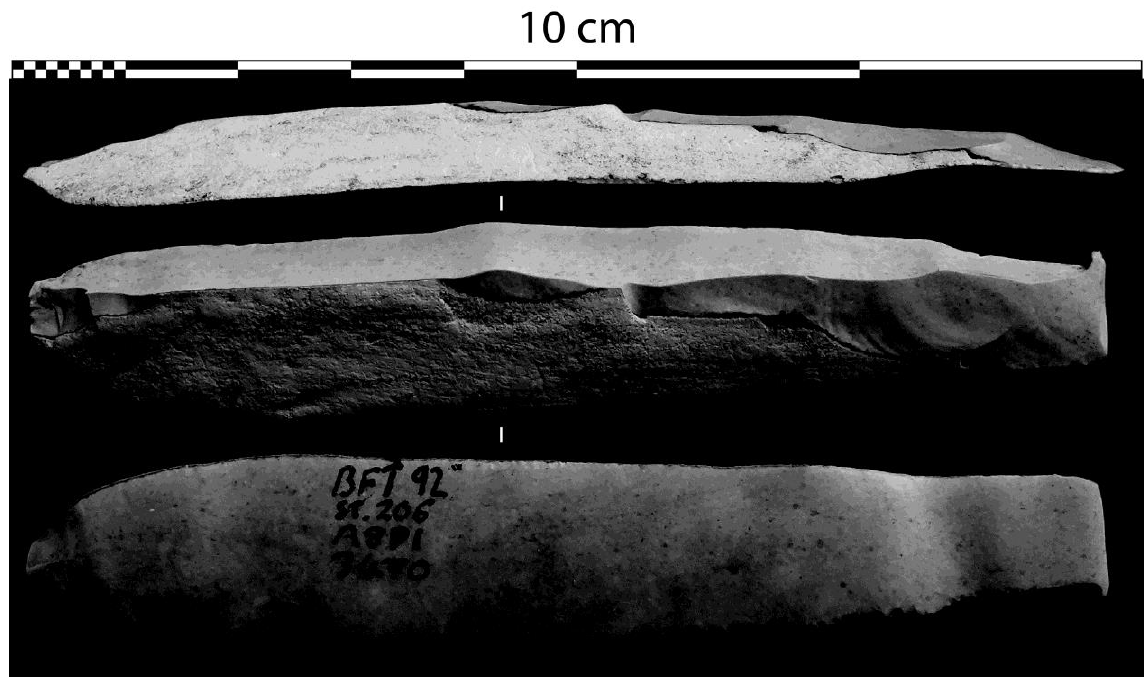
Figure 3. Photograph of one flank blades in Ghlin flint discovered in Bucy-le-Long “la Fosse Tounise”